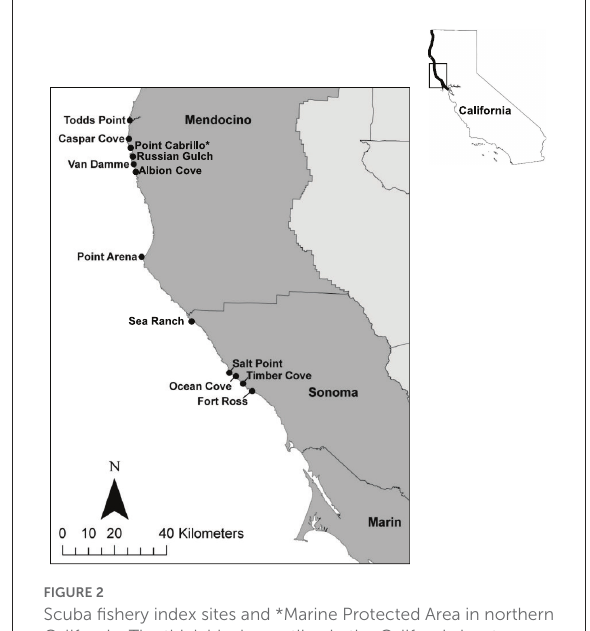
FIGURE2 Scuba fishery index sites and *Marine Protected Area in northern California. The thick black coastline in the California inset map indicates the area dominated by bull kelp (San Francisco to the Oregon